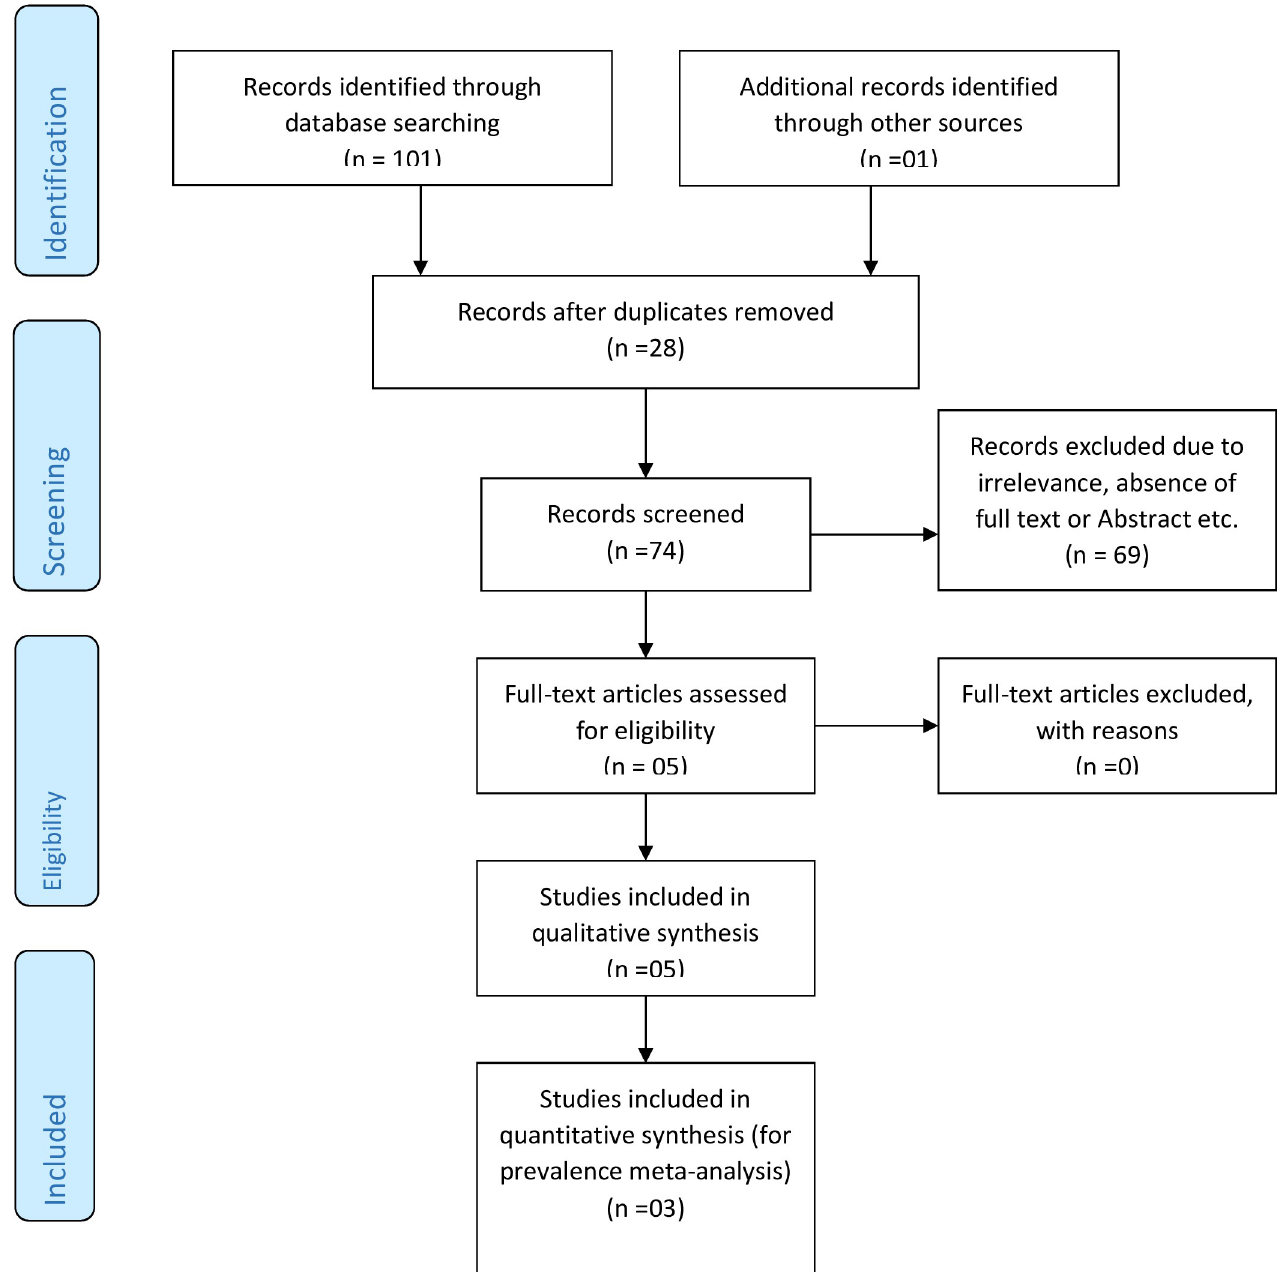
Fig 1. PRISMA flow chart of study selection for systematic review and meta-analysis of prevalence of neonatal near miss in Ethiopia.